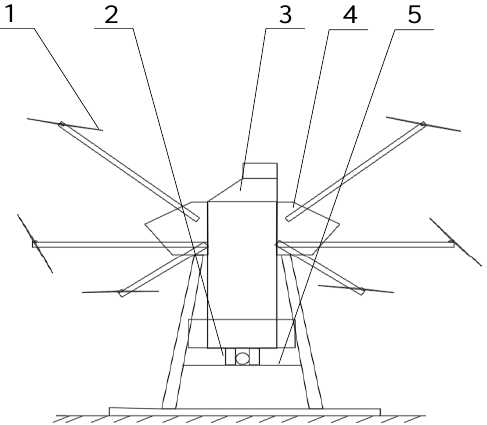
Figure 1. Schematic of the Trichogramma delivery system. 1. Rotor; 2. Release device; 3. Release box; 4. Plant protection UAV; 5. Fixed plate.